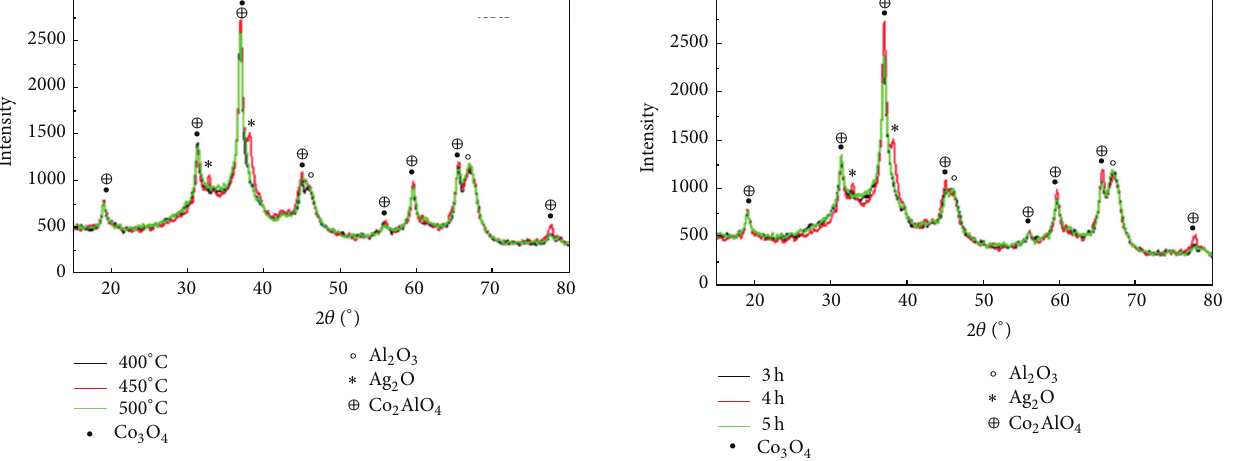
Figure 9: The XRD of different cobalt calcination temperatures.